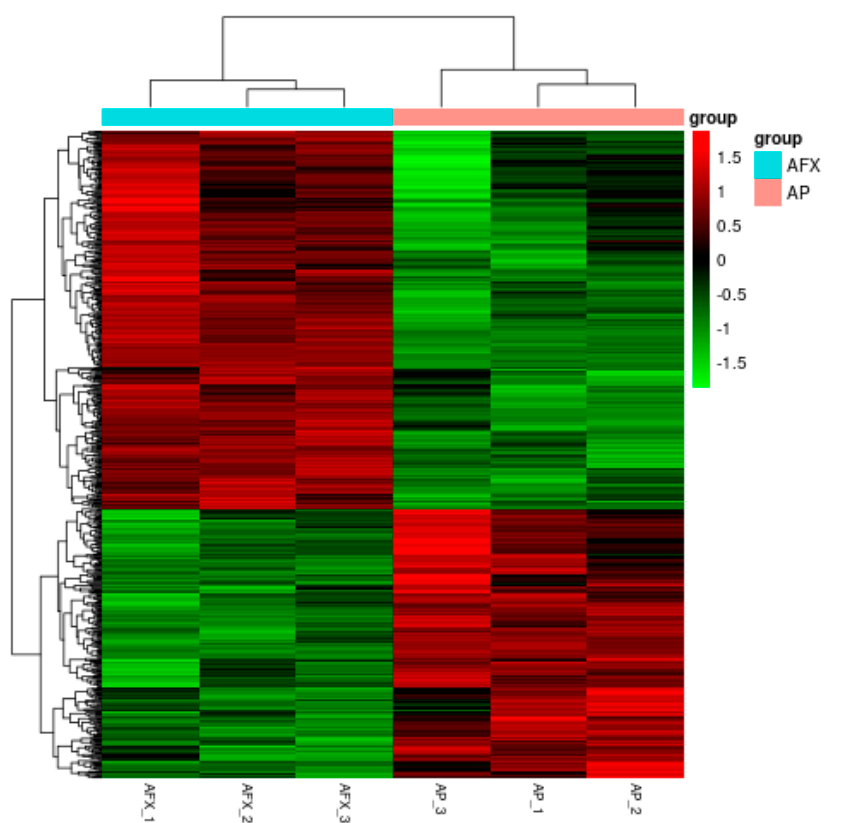
Figure 4. Cluster analysis of the DEGs derived from the AP and AXP groups. AP, the P. pastoris cell expressing the antibacterial peptide (autolysis group) ; AXF, the P. pastoris cell expressing the aflatoxin-detoxifizyme (ADTZ) (non-autolysis group); p -values < 0.05 were designated as differentially expressed genes (DEGs).